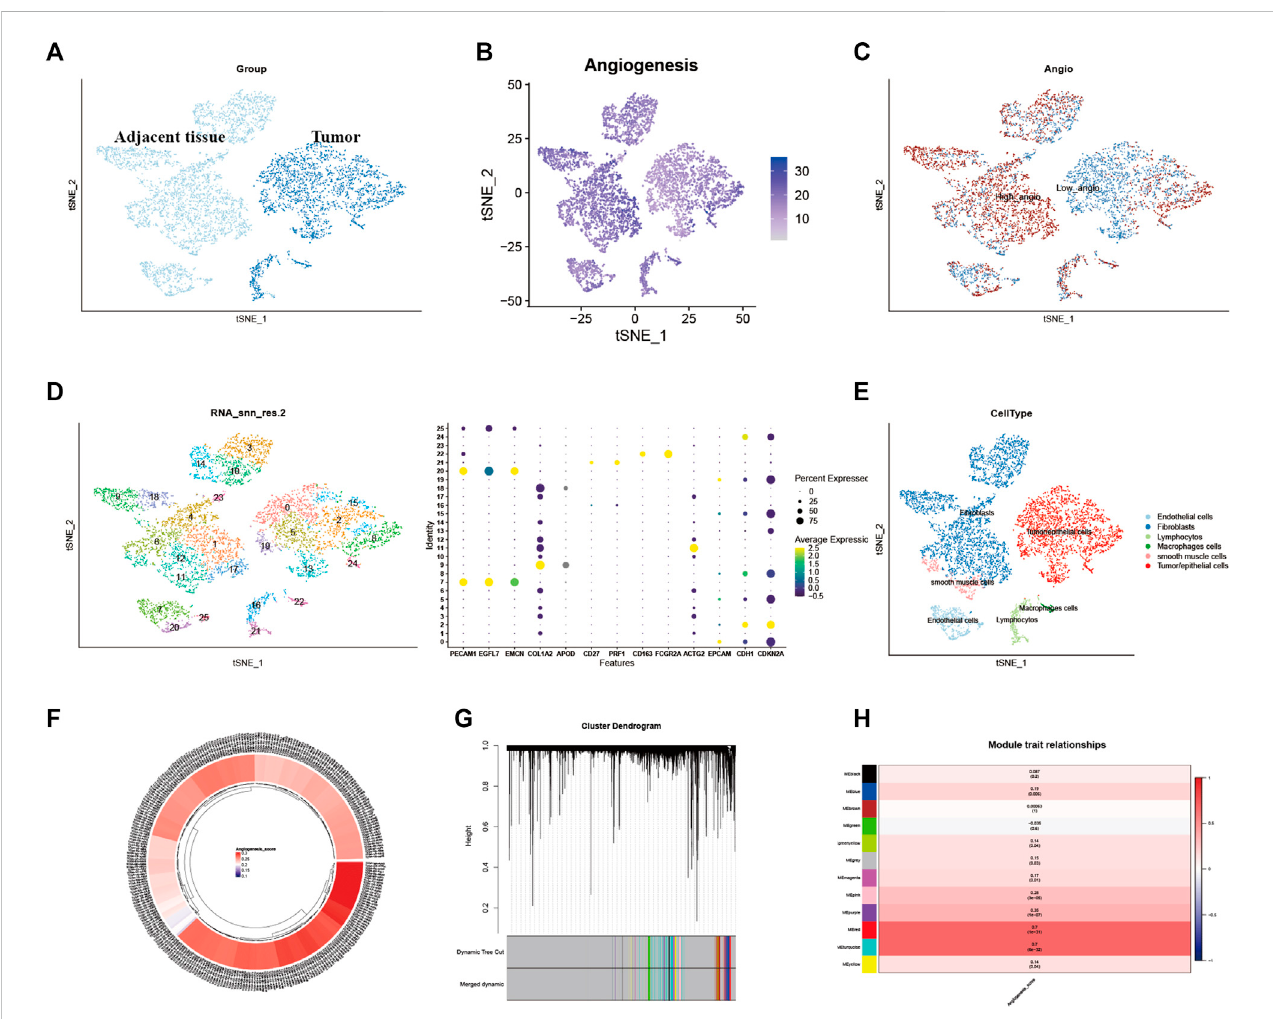
FIGURE 2 Identi fi cation of Angiogenesis-Related Different Genes and Selection of Module Genes by WGCNA. (A) . Grouping of samples in single-cell sequencing dataset GSE168652. (B) . The angiogenesis scores for per-cell of GSE168652. (C) . Distribution of high and low angiogenesis score cell groups. (D) . Samples were clustered by KNN clustering algorithm. (E) . Localization of six type of major cells in the sample. (F) . Angiogenesis score for each cervical cancer patient from TCGA-CESC cohort. (G,H) . Blue, greenyellow, magenta, purple, red, turquoise, pink, and yellow modules were closely related to angiogenesis- related